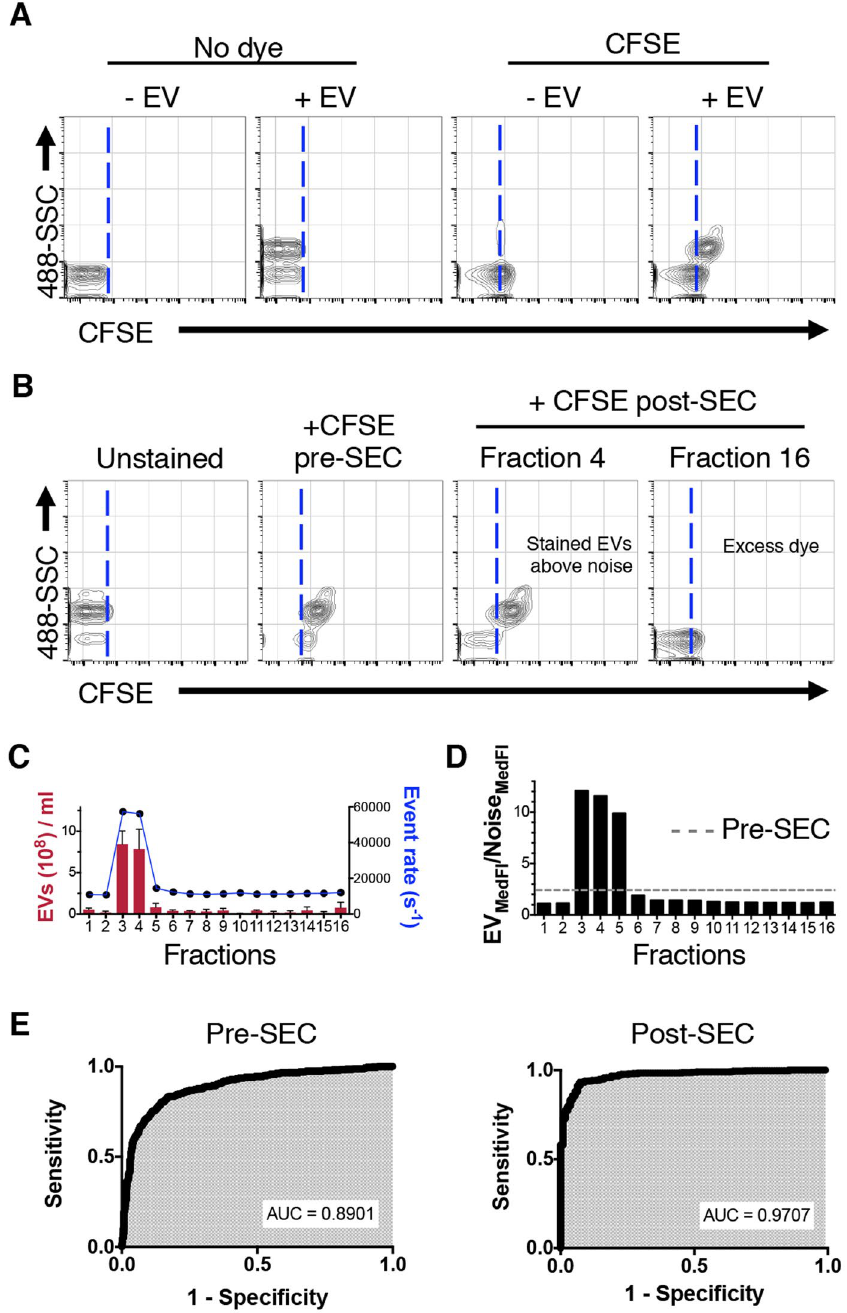
Figure 4. Size exclusion chromatography removal of unbound dye increases the signal to noise ratio of CFSE- labeled EVs. ( A ) Representative plots of fluorescence detection on unstained EVs, CFSE-labeled EVs and EV- lacking controls, analyzed by nanoFACS. Note a shift on the background reference noise fluorescence, due to the presence of free fluorescent CFSE dye in the sample 22, 23 . ( B ) Representative dot plots depicting 488-SSC and CFSE fluorescence showing unstained and CFSE-stained EVs before and after size exclusion chromatography. Dotted lines in A and B separate the CFSE - and CFSE + events, and were set on the limit of the background reference noise population in the unstained EV plot. ( C ) EV concentration analysis by NTA (in red) and total event rate by nanoFACS (in blue) of each fraction collected after size exclusion chromatography. NTA data shows the mean of three acquisitions and SD. ( D ) Ratio between EV and background reference noise median fluorescence intensity after eluting from size exclusion column (gated as in Fig. 2E). Dashed line shows the ratio before chromatography. Analysis of size exclusion chromatography fractions was performed twice with similar results. ( E ) ROC curves to assess specificity and sensitivity of EV identification by fluorescence. EV, extracellular vesicle; FSC, forward and SSC, side light scatter; MedFI, Median Fluorescence Intensity. SEC, size exclusion chromatography; ROC, Receiver Operating Characteristic; AUC, Area Under the Curve; FSC, forward scatter; SSC, side